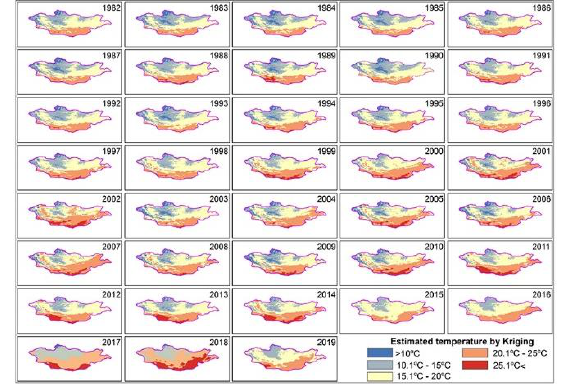
Figure 5. Spatial distribution map of summer air temperature estimated by Kriging over Mongolia from 1982 to 2019.